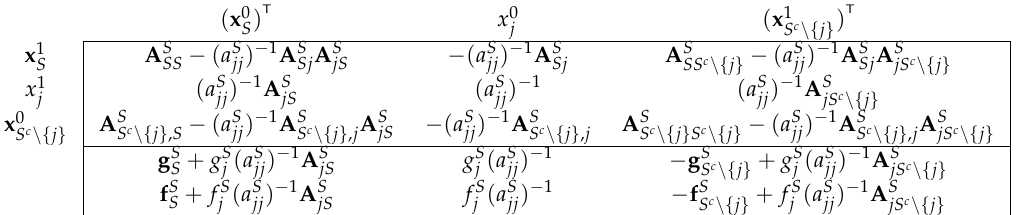
Table 2. Tableau for S ∪ { j } -active BFS, after pivoting on a S